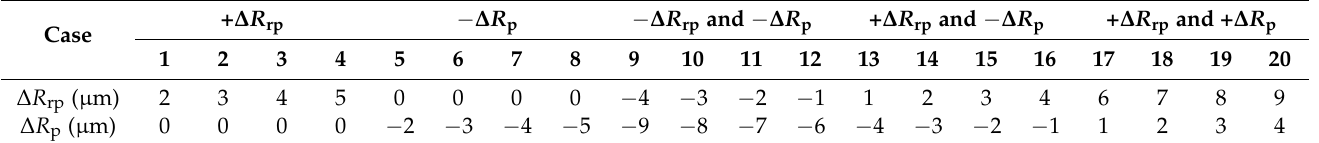
Table 2. Cases of different